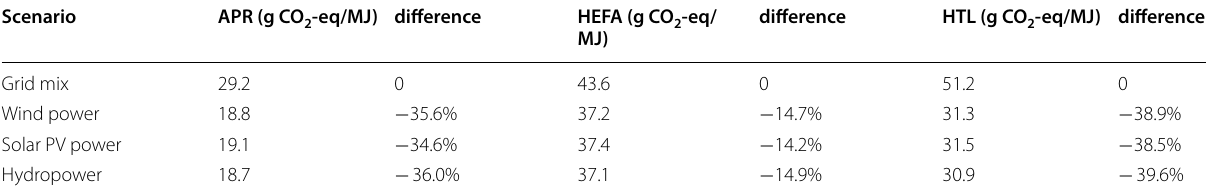
Table 6 Sensitivity analysis on power input